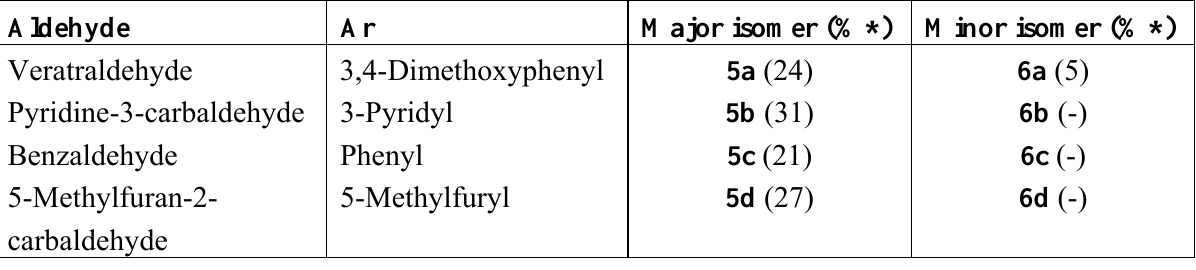
Table 1. Condensation products of asparagine, NMM and aryl(heteroaryl)aldehydes.